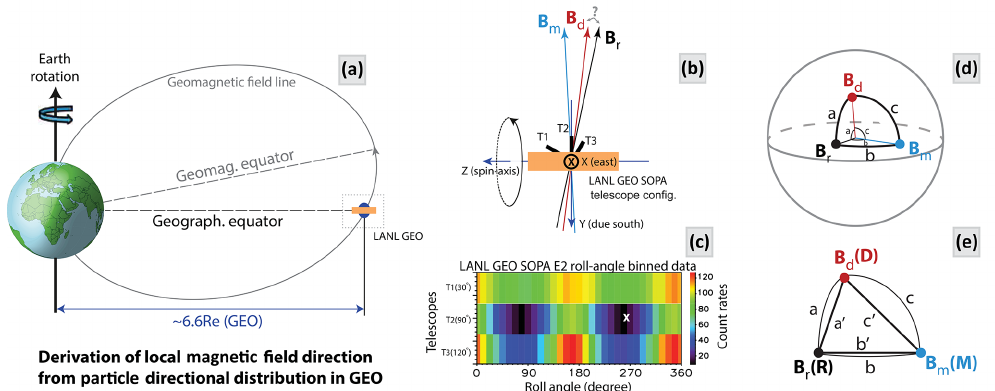
Figure 1. LANL GEO satellites measure electron directional distributions. (a) Side view of the GEO orbit. A LANL GEO satellite is usually close to but not exactly in the geomagnetic equator due to the tilted geomagnetic dipole field. (b) Rotation of the satellite platform allows the three SOPA telescopes (T 1 , 30 ◦ to the spin axis z ; T 2 , 90 ◦ , and T 3 , 120 ◦ ) to sample directional distributions of electrons; meanwhile, the unit local magnetic field from the empirical model ( B m in blue), the one derived from electron distribution ( B d in red), and the real direction ( B r in black, if measured) can be different. The goal of this work is to determine the angle between B d and B r (indicated by the question mark). (c) One example electron distribution measured by SOPA. Count rates are sorted by the roll angle (defined as the azimuthal angle in the satellite spin plane: 0 ◦ along the x (due east) direction and 90 ◦ along y (due south)), and a derived magnetic field direction from symmetry of the distribution is marked by the white cross. The very low counts for T 2 are measured close to the loss cone. (d) In a unit sphere, the three magnetic vectors form a polar triangle (cid:49)B d B r B m , whose side lengths ( a , b , and c) are proportional to the angles between each pair of unit vectors. (e) Polar triangle (cid:49)B d B r B m can be approximated by the planar triangle (cid:49)DRM in this